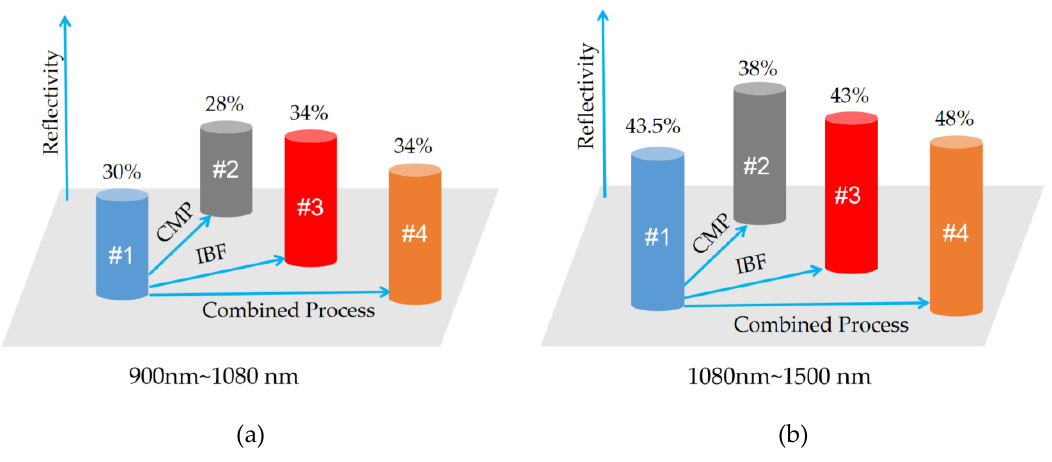
Table 10. Comparison of the reflectivity of four samples